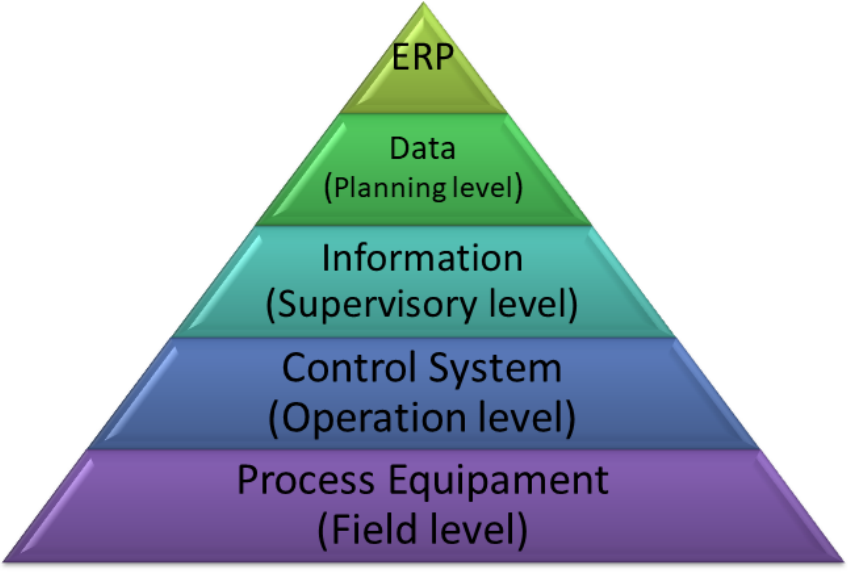
Figure 6. Automation